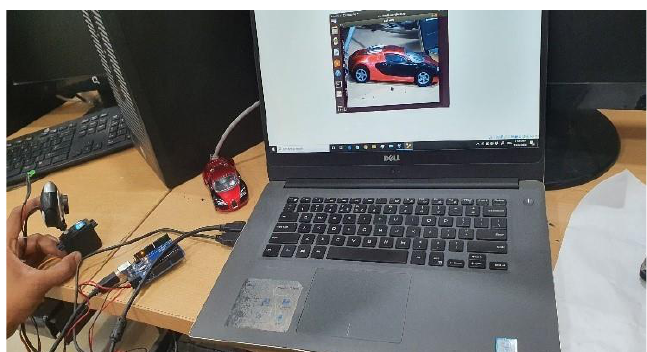
Figure 3. System Setup